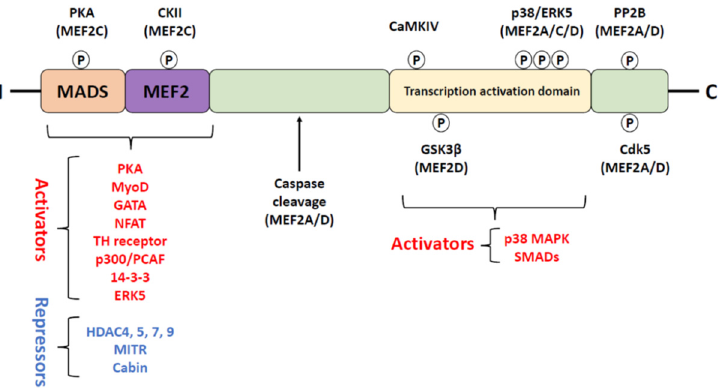
Figure 2. MEF2 protein interactions and the mechanisms of activity regulation. MEF2 transcription factors contain MADS at their N-terminus that mediates homo and heteromerization and DNA binding. Adjacent to MADS is the MEF2 domain that regulates cofactor binding and determines DNA-binding affinity. Several MEF2-interacting partners have been identified. They may either stimulate (activators, red color) or repress MEF2 activity (repressors, blue color). PKA (protein kinase A), CKII (casein kinase II), CaMKIV (Ca 2+ /CaM-dependent protein kinase type IV), p38 kinase, ERK5 (extracellular signal-regulated kinase type 5) and PP2B (protein phosphatase type 2B) increase MEF2 activity, whereas GSK3 β (glycogen synthase kinase 3 β ), cdk5 (cyclin-dependent kinase type 5) and caspase cleavage inhibit MEF2 activity. Adapted from [33].